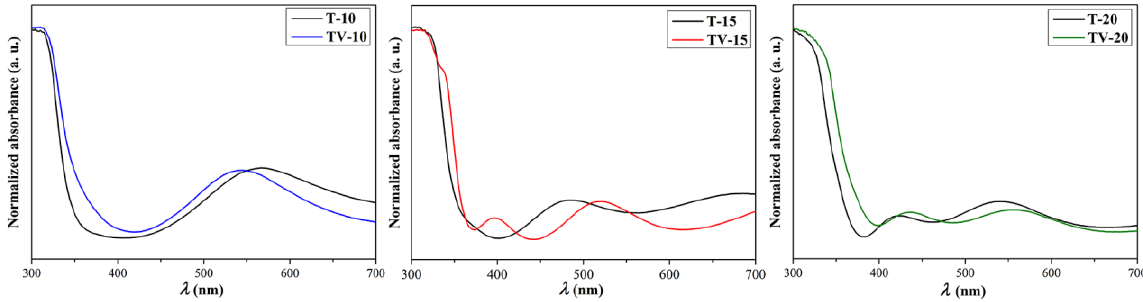
Figure 5. Comparison of UV-Vis spectra of nanotubes with and without vanadium oxide